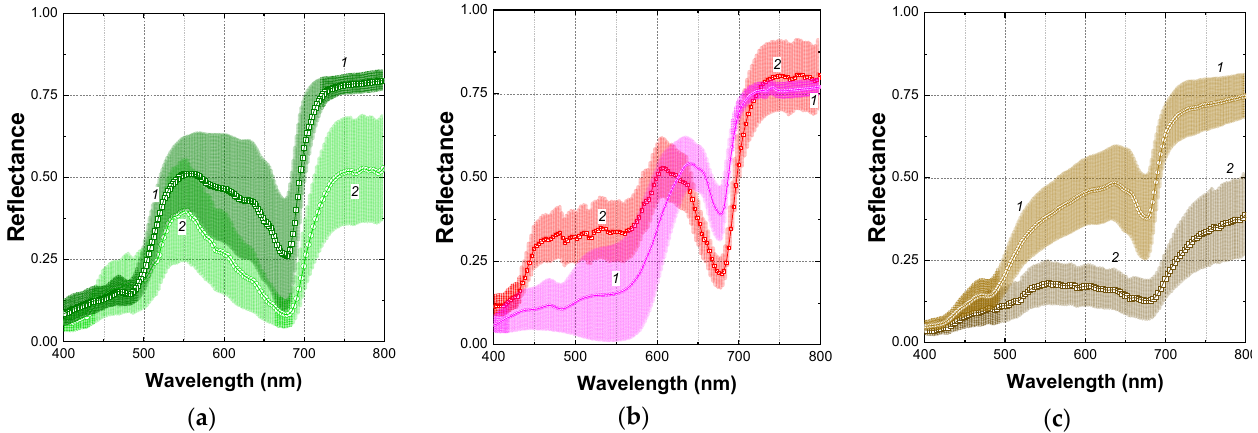
Figure 2. Typical reflectance spectra of ( a ) healthy green; ( b ) healthy red, and ( c ) damaged brown apple fruit surface regions. Spectra measured by conventional spectrophotometer (Agilent Cary Bio 300) are shown (curves 1 ) together with those extracted from hyperspectral reflectance images recorded with SPECIM IQ snapshot hyperspectral camera at ambient illumination (curves 2 ) together with their standard deviation (shaded areas). Corresponding raw reflectance spectra can be found in the supplementary data file.